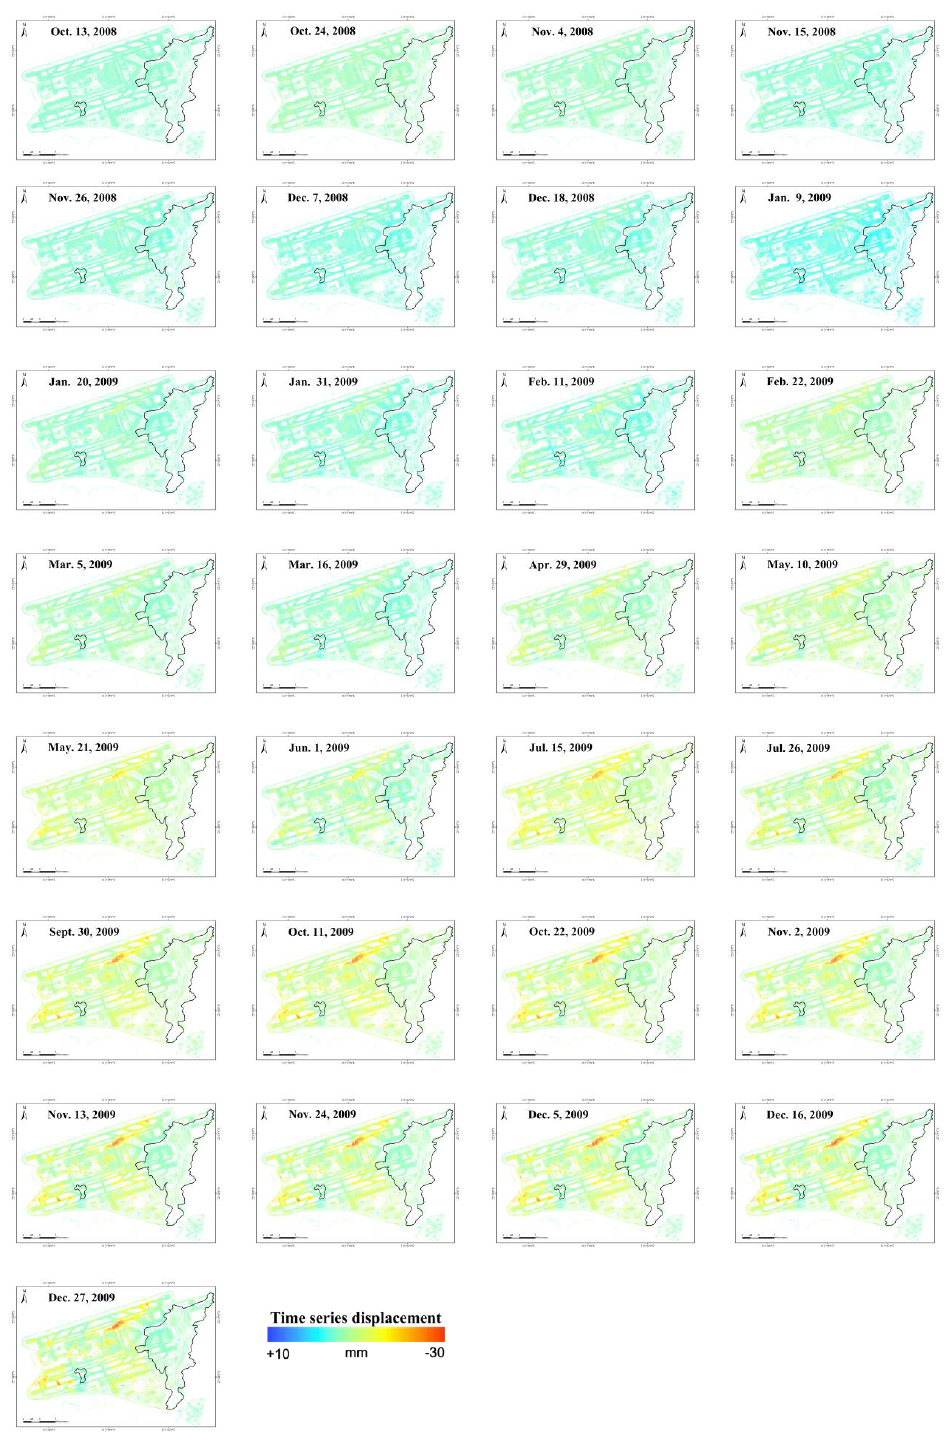
Figure 9. The LOS displacement time series over HKIA retrieved by the proposed DSI strategy from TerraSAR-X Spotlight images.